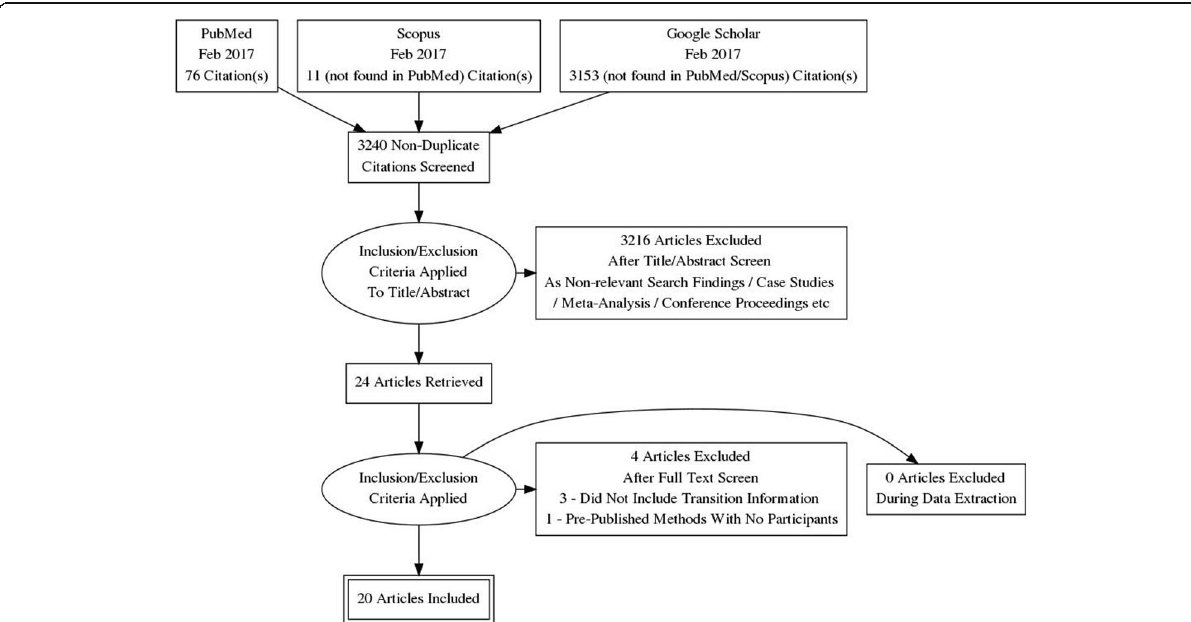
Fig. 1 PRISMA study selection flow chart for the review. The relevant, non-duplicate citations were screened and included in the review if (1) the methods included individuals with previous running experience, of which their experience level was clearly reported; (2) the study prescribed specific details for transitioning to minimal footwear including the proposed exposure to minimal shoes; (3) the study included the use of “ true minimal ” shoes, based on the published definition; and (4) the study was longitudinal and